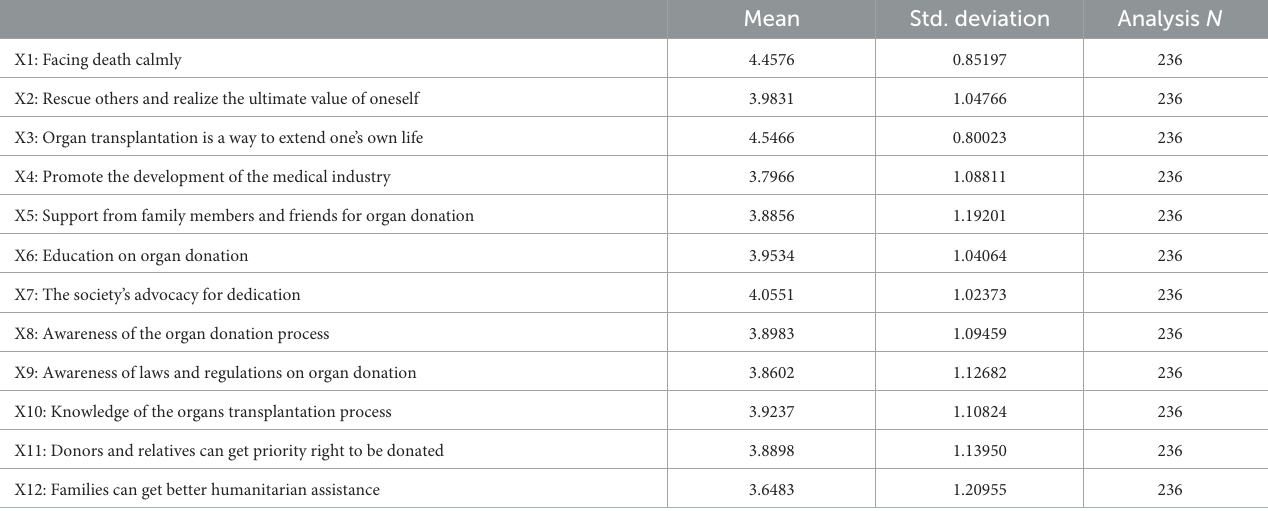
TABLE 4 Descriptive statistics (willingness to donate organ).